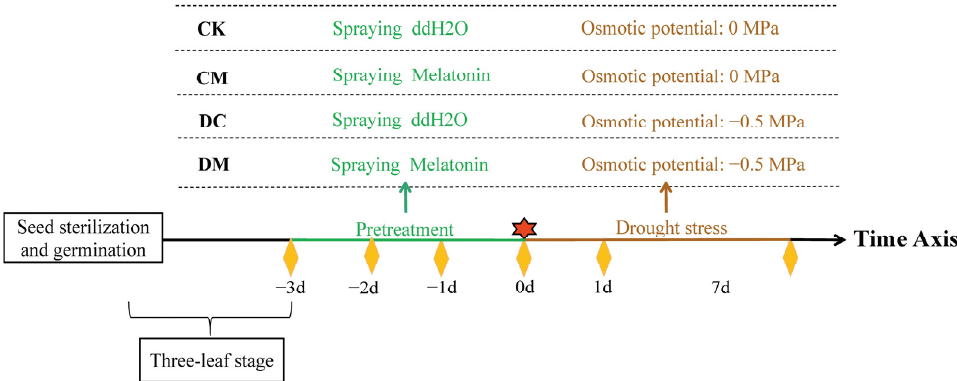
Figure 11. Diagram of spraying melatonin (refer to a previous report